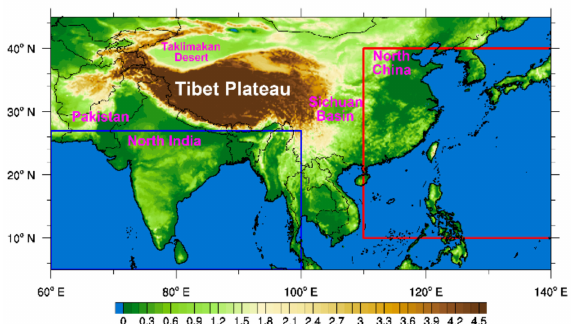
Figure 1. The topography (km) of study area, red and blue rectangles correspond to the East Asian Summer monsoon (EASM) and the South Asian summer monsoon (SASM) regions, respectively.